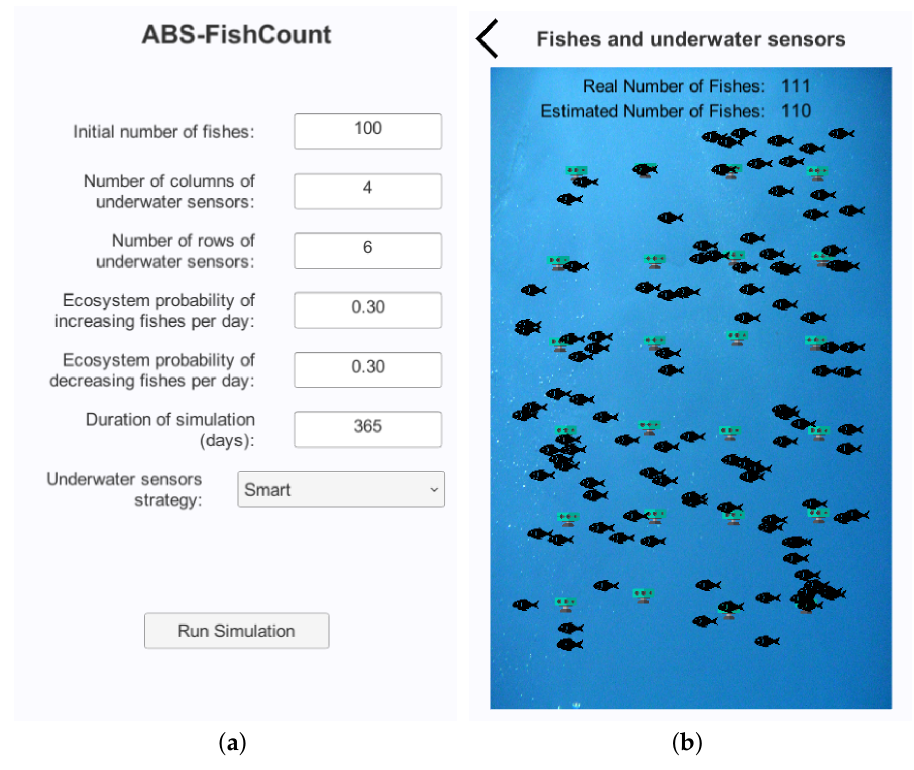
Figure 1. User interface (UI) of ABS-FishCount (an agent-based simulator of underwater sensors for measuring the amount of fishes). ( a ) input screen; ( b ) output